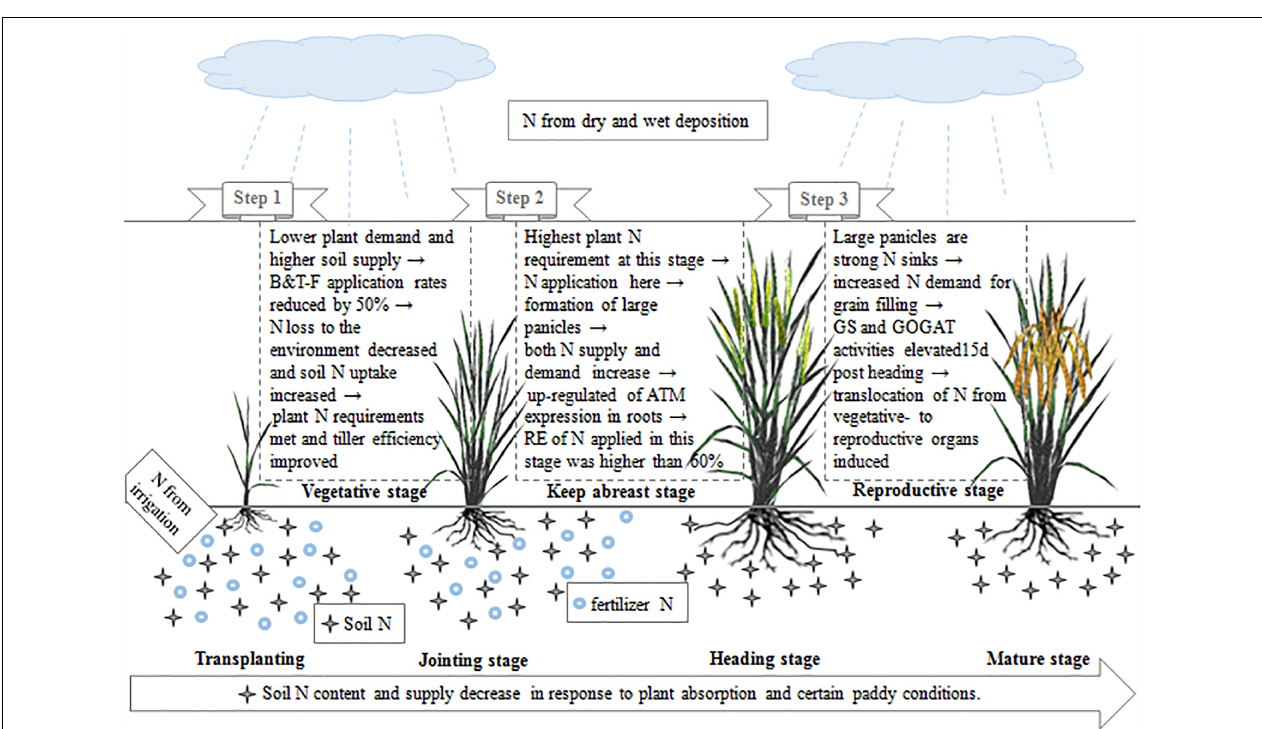
FIGURE 9 | Mechanism by which nitrogen utilization efficiency is improved in indica hybrid rice in response to optimized nitrogen management.